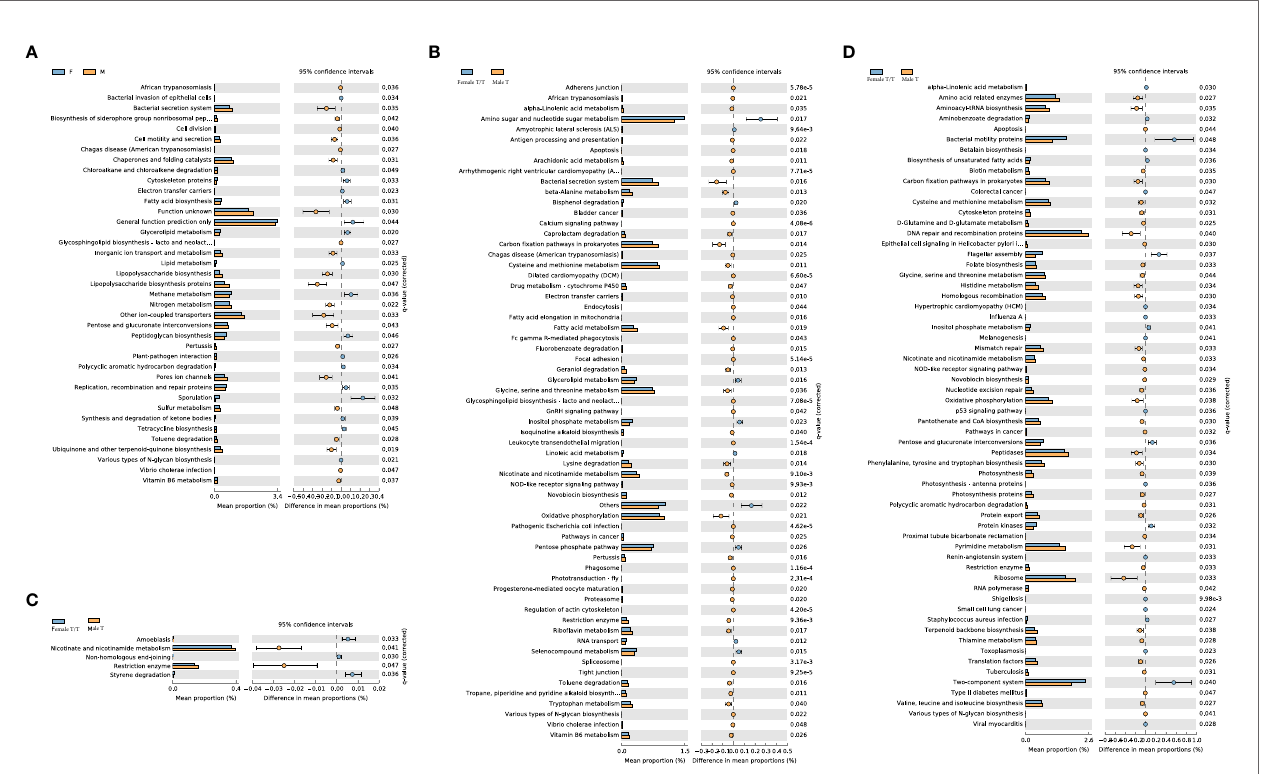
FIGURE 7 | Different metabolic pro fi les of gut microbiota between Twins/Triplets. Kruskal-Wallis test was used to compare the difference of the KEGG pathway (level 3). Benjamini-Hochberg procedure was used to decreases the false discovery rate for multiple test corrections. The p-value was set as 0.05. (A) KEGG pathway difference between female and male co-twins of the Mixed T/T pairs during the 3 rd week of NICU stay. (B) KEGG pathway difference between Female T/T and Male T during the 2 nd week of NICU stay. (C) KEGG pathway difference between Female T/T and Male T during the 3 rd week of NICU stay. (D) KEGG pathway difference between Female T/T and Male T during the 4 th week of NICU